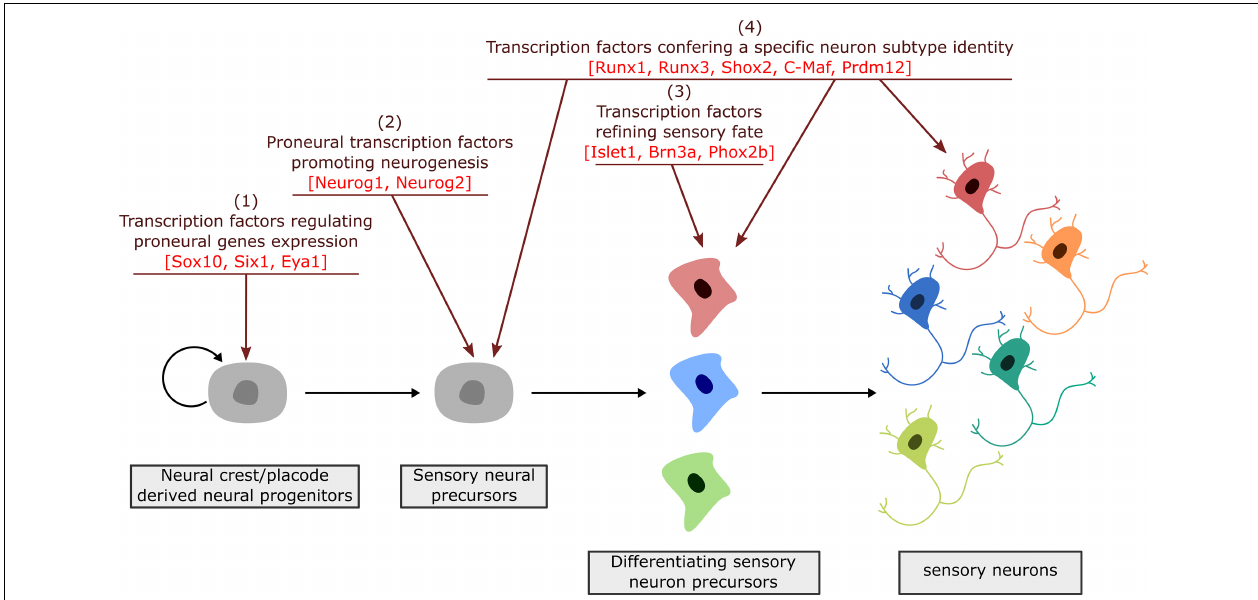
FIGURE 3 | Successive steps of sensory neuron differentiation. The emergence of sensory neurons from placodal/neural crest derived cells involves transcription factors acting in a timely appropriate manner to drive sensory neuron specification and diversification. Placodal/neural crest specific TF are first required to initiate the induction of proneural factors (1). Proneural factors then act in sensory neuron precursors (neuroblasts) to select a neuronal fate and block their proliferation (2). Their activation is followed by the expression of broadly expressed TF that further refine and secure a sensory identity (3). Finally, TF with a more restricted expression pattern, acting all along the differentiation process, drive transcriptional programs required for the acquisition of dedicated sensory subtype phenotypes (4).